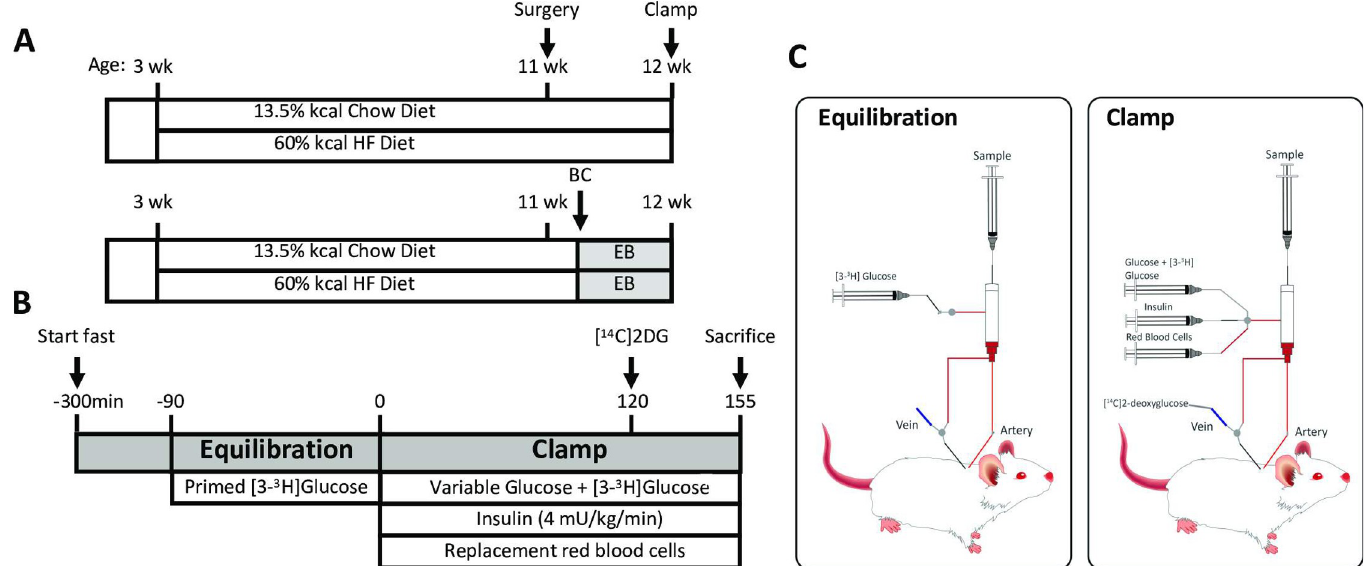
Fig 1. Study design and insulin clamp protocol for the conscious unrestrained mouse. A : All mice were randomized to either chow or HF diet at 3 weeks of age. Studies were performed at 12 weeks of age. BC: body composition; EB: energy balance. B : Insulin clamp protocol. C : Insulin clamp setup. Mice are never handled nor retrained after they are hooked up to the swivel (t = -90min). [ 14 C]2DG: 2[ 14 C]deoxyglucose.